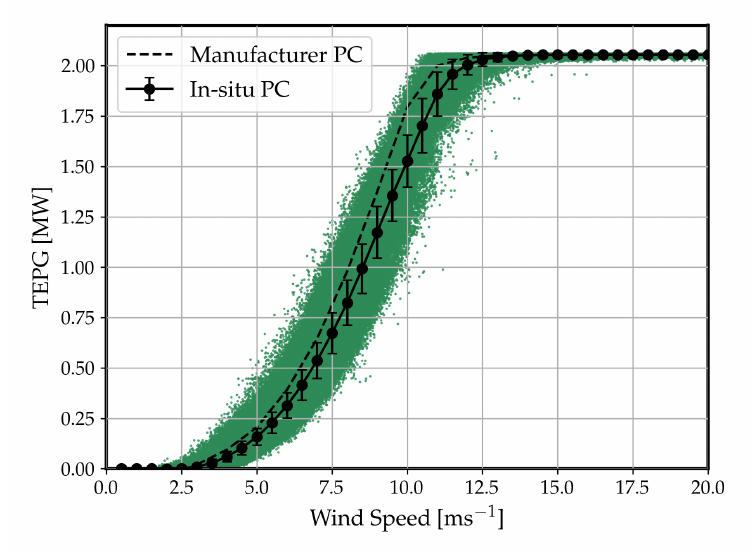
Figure 5. In situ power curve. The ten minute average data points used to establish the power curve are shown in green. The mean and standard deviation of the power binned in a 0.5 ms − 1 wind speed interval are shown in black. The dashed lines represent the manufacturer’s power